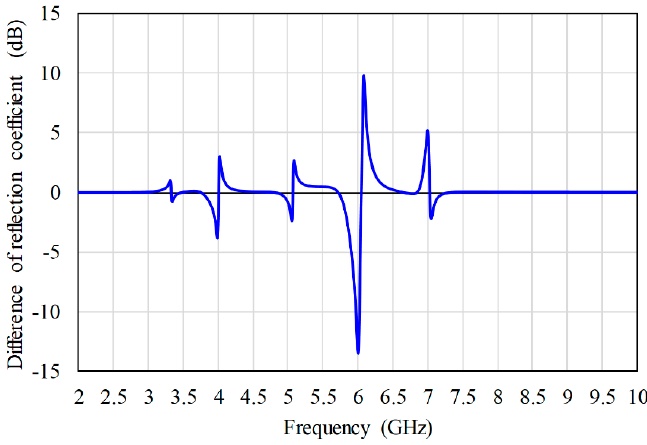
Figure 9. Amplitude difference between vertically and horizontally polarized S 11 for code “1010101010”.